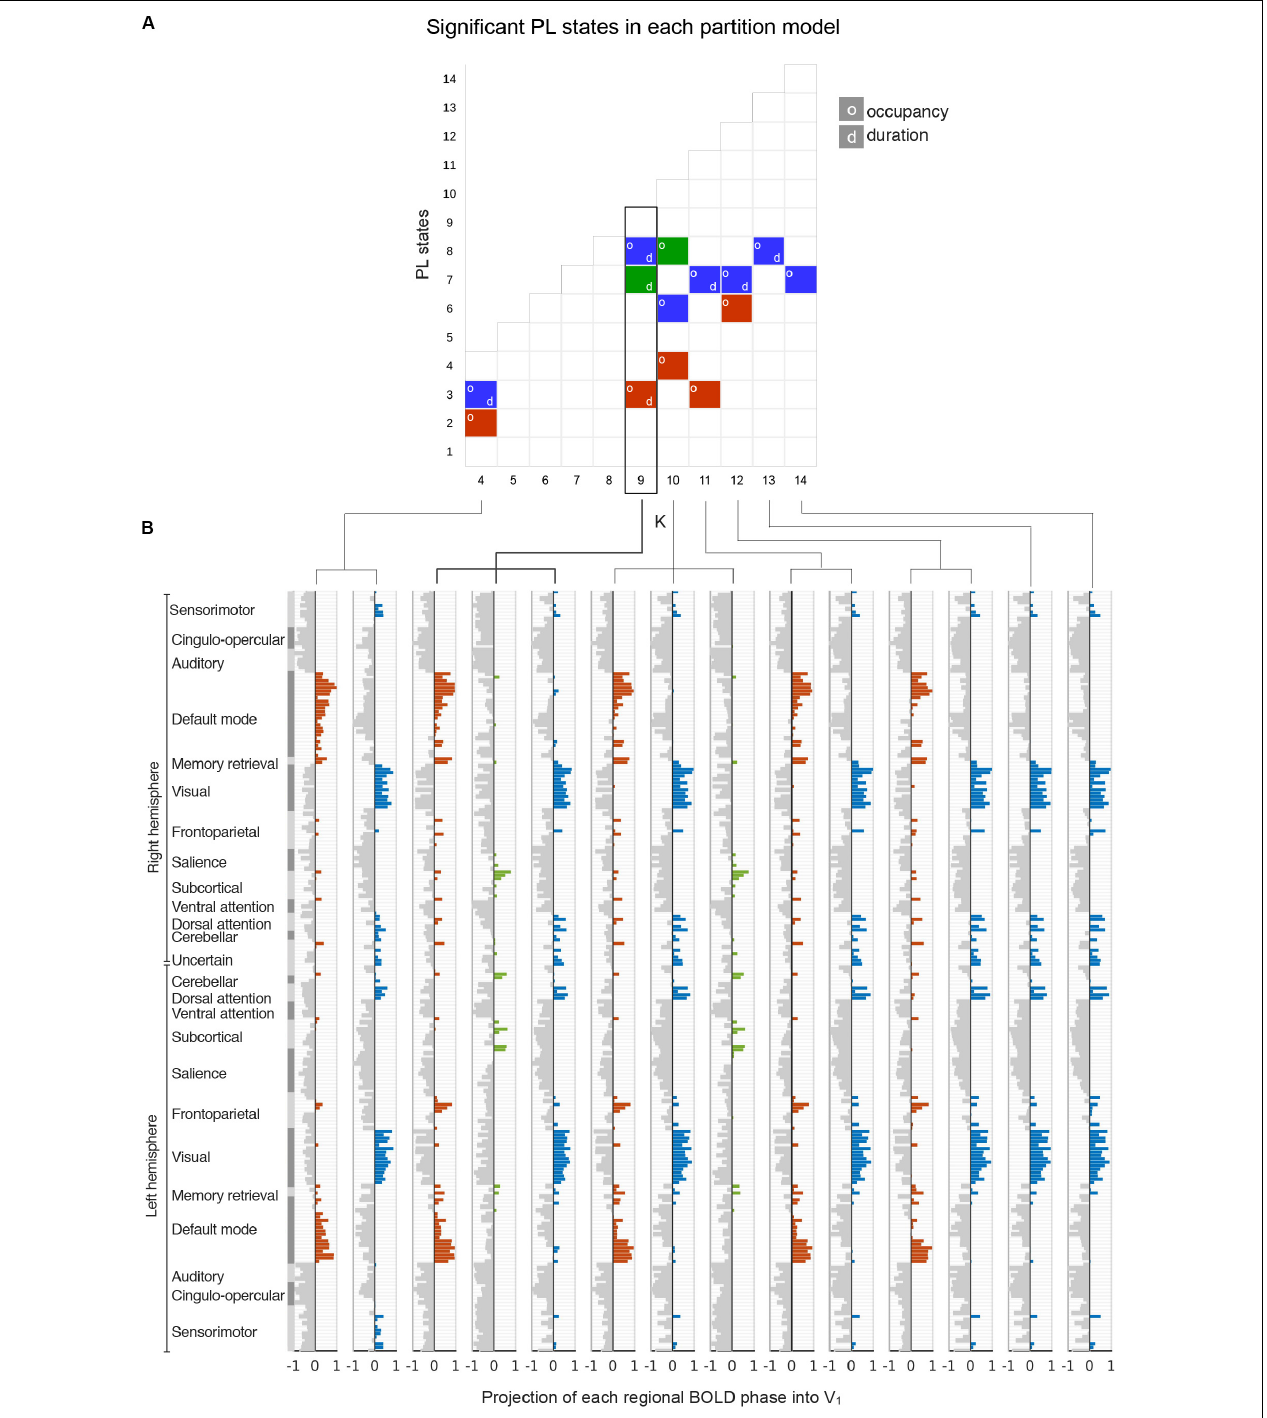
FIGURE 3 | Detection of significant between-group differences in PL states across partition models. (A) Each square in the matrix represents a PL state (or cluster) obtained for each k-means partition model with k varying between k = 4 and k = 14 ( x -axis). PL states that are significantly different between low and high MDI (p-FDR < 0.05), either in terms of percentage of occupancy (o) or duration (d), are indicated by colored squares. Since significantly different PL states obtained for different k were found to represent variant forms of 3 underlying configurations of BOLD phase locking (see panel B), we used a color-code (blue, red, green) to illustrate how these different configurations occurred across k. (B) The cluster centroids, Vc, of significantly different PL states identified in panel A are represented as bar plots. Here, each horizontal bar represents the BOLD phase in each of the N = 223 brain regions projected into the corresponding leading eigenvector (captured by the N elements in Vc). The regions n whose BOLD signal is phase-shifted (Vc(n) > 0) were colored using the same color-code from panel A. MDI, Major Depression Inventory; PL, phase-locking.